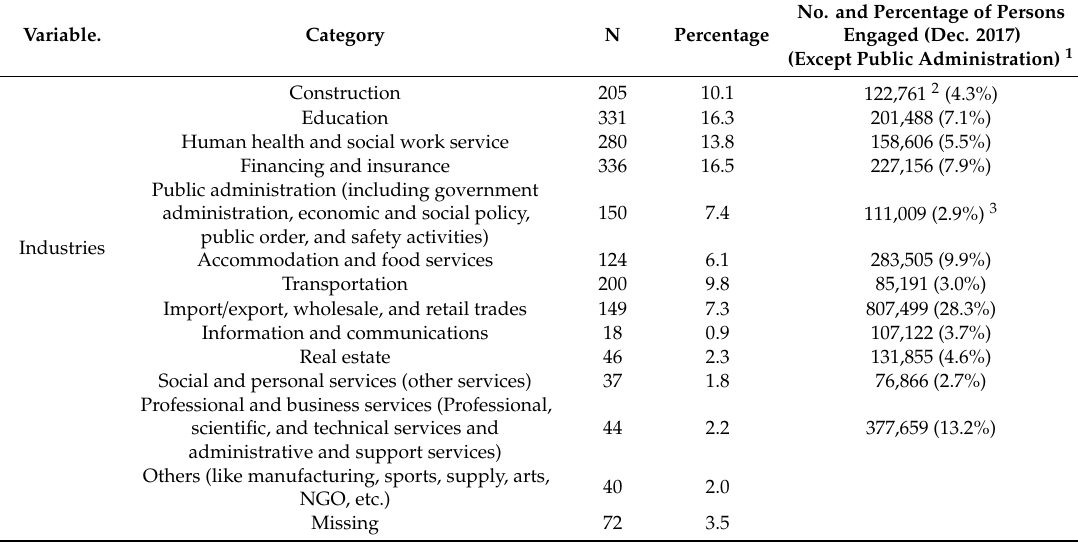
Table 1. Sample distributions in eight major industries in Hong